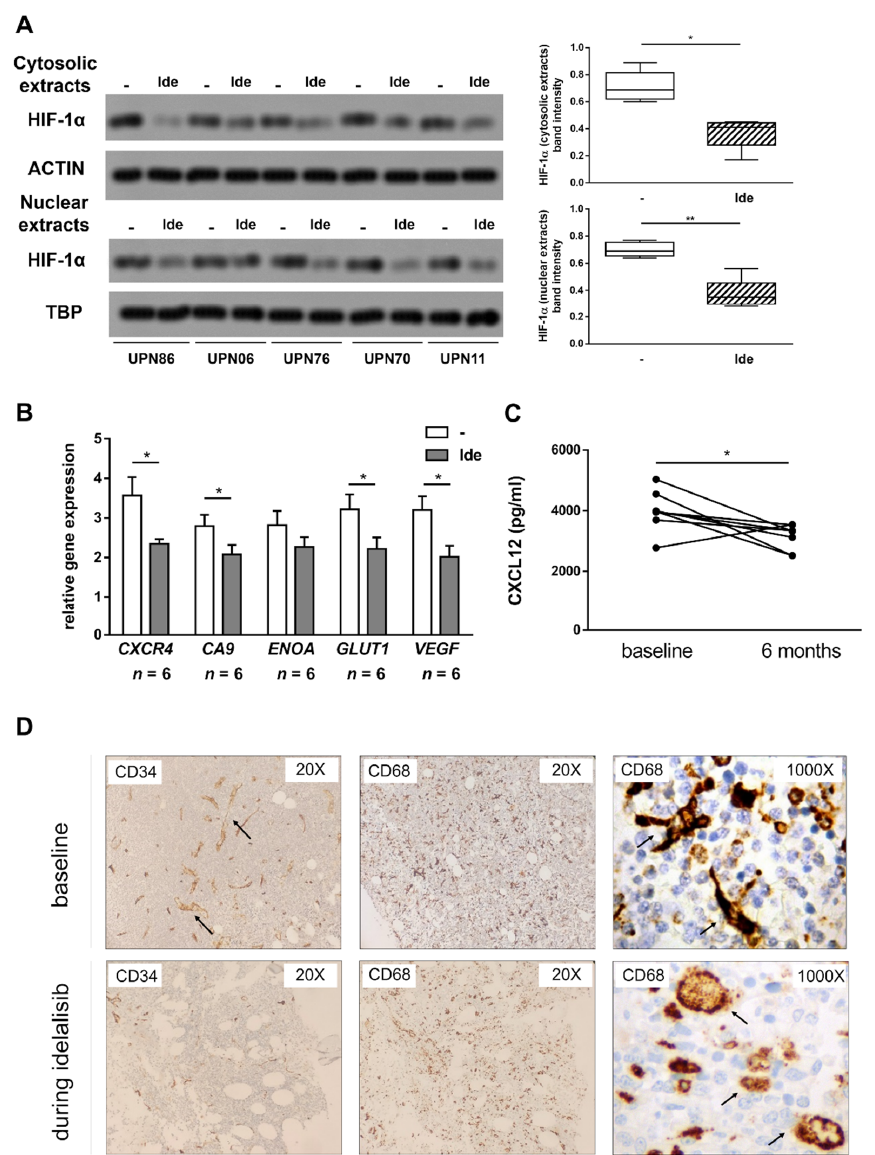
Figure 6. Idelalisib treatment downregulates HIF-1 α in CLL cells, reduces serum CXCL12 and modifies the BM microenvironment. Leukemic cells isolated from CLL patients treated for one month with idelalisib were evaluated for HIF-1 α expression by WB and for the expression of the HIF-1 α target genes CXCR4, CA9, ENOA, GLUT1 and VEGF by RT-PCR. Compared to the baseline, a reduced cytosolic and nuclear expression of HIF-1 α ( A ), and a decreased expression of the analyzed target genes ( B ) were detected. In patients’ sera, CXCL12 concentration decreased after 6 months of treatment with idelalisib ( C ). Immunohistochemical analyses performed on BM sections collected from CLL patients during idelalisib treatment showed, compared to the baseline, a reduced vessel density, highlighted by anti-CD34 immunostain- ing, and an enrichment in the CD68+ monocytes/macrophages characterized by a round shape morphology and no cellular extensions ( D ). In ( A ), blots from the analysis of 5 independent experiments (with UPN) and cumulative band intensity data obtained are shown. In ( B ), bar graphs represent mean results obtained from 6 experiments together with SEM. In ( C ), a line graph represents individual data values for the same sample in each timepoint. In ( D ), immunohistochemistry